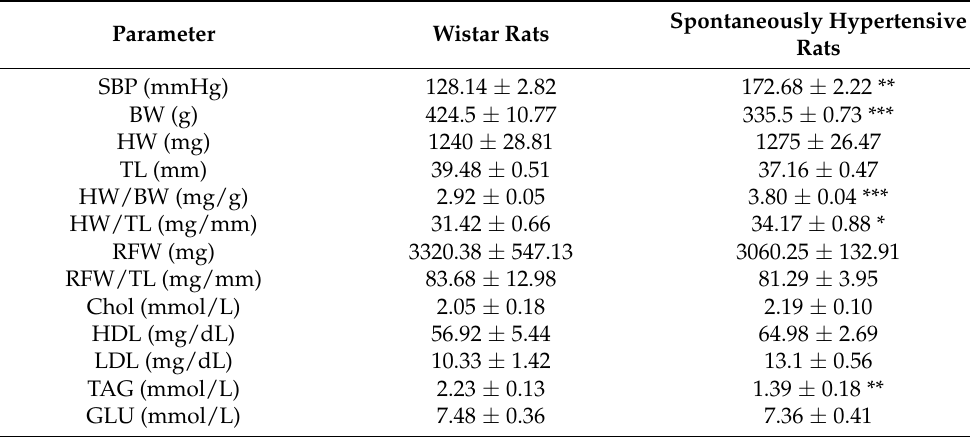
Table 1. General characteristics of experimental